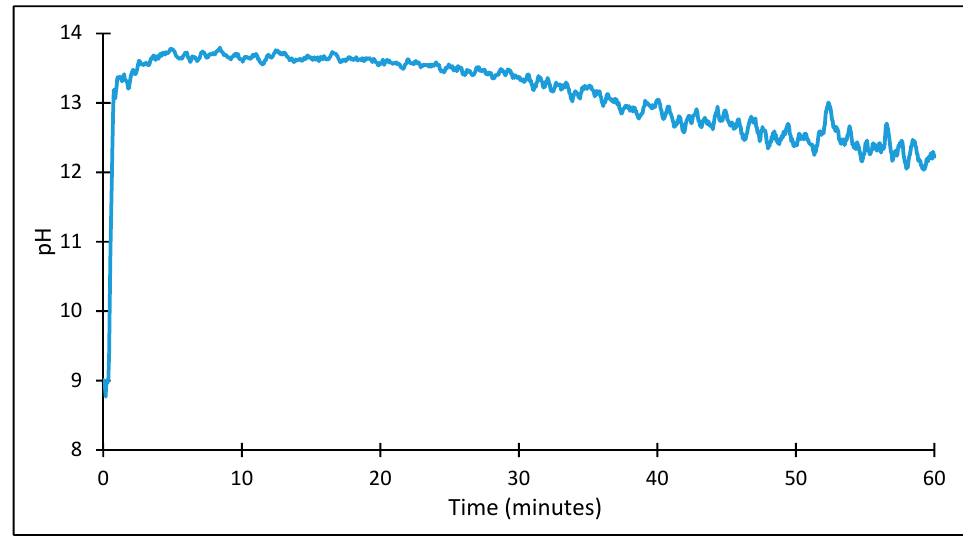
Figure 22. pH values of fresh geopolymer paste using Method VII.